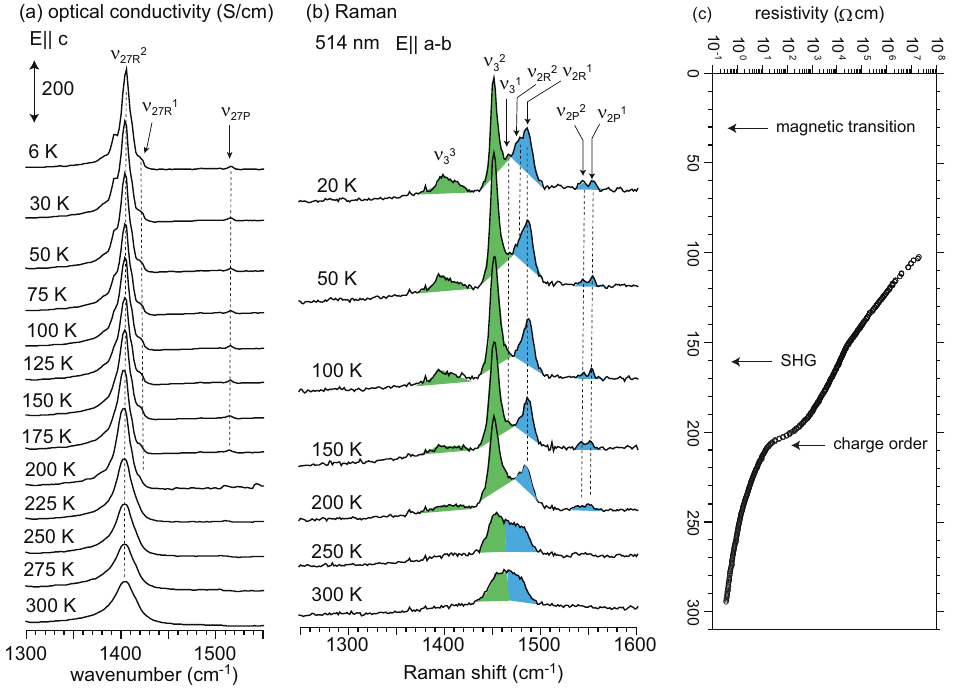
Figure 26. Temperature dependences of the ( a ) Infrared-active ν and ν modes; and ( c ) electrical resistivity in α′ -(BEDT-TTF) ν 2 3 argument of assignment. Figure 26a,c are taken from ref.